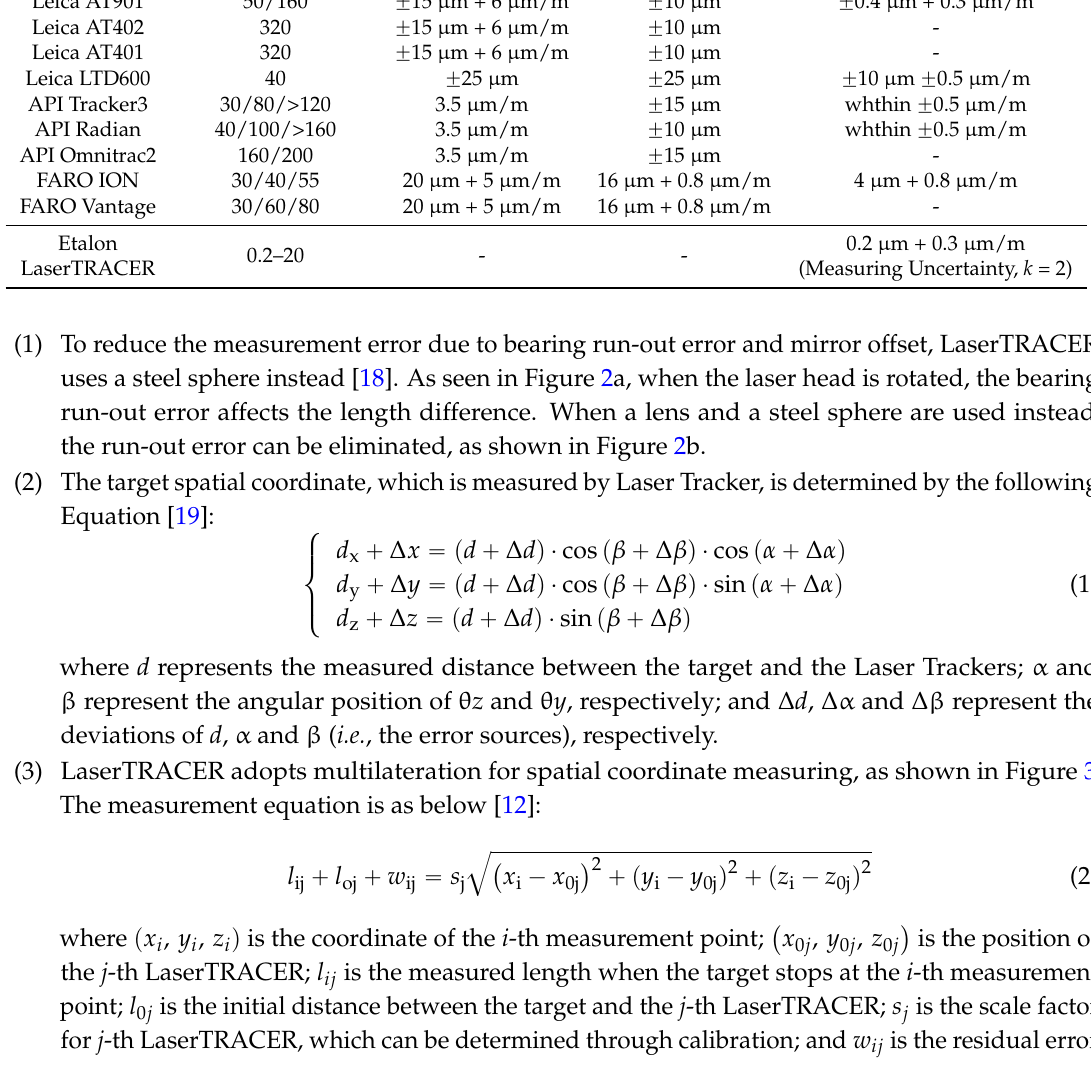
Table 1. Comparison of measurement uncertainty for different auto-tracking laser interferometers (ATLIs) (the value is from manufacturer catalogs). (Note: ADM = Absolute Distance Measurement; IFM = Interferometer; AIFM = Absolute Distance Measurement + Interferometer). Mode Working Range (m) Angular Accuracy Leica AT960 40/160